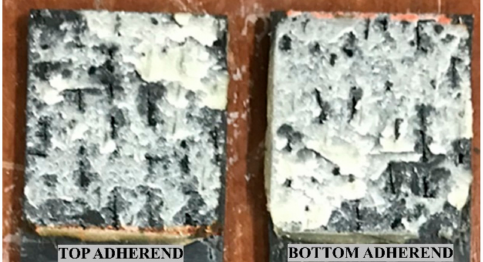
Figure 10. Failure surfaces of adhesively bonded ELC_ELC